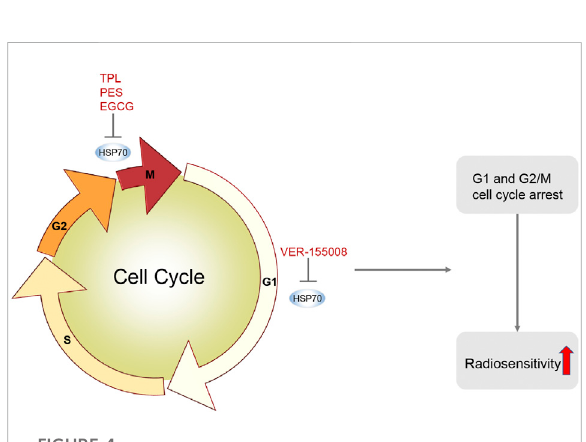
FIGURE 4 HSP70 Inhibitors Induce Cell Cycle Arrest. HSP70 inhibitors induce cell cycle arrest by inhibiting HSP70. For example, TPL induces G2/M phase arrest in nasopharyngeal carcinoma; VER- 155008inducesG1phasearrestinpleuralmesothelioma;PES induces G2/M phase arrest in oral squamous cell carcinoma; EGCG induces G2/M phase arrest in MCF-7 cells in breast cancer. HSP70 inhibitors induce cell cycle arrest, make tumor cells more sensitive to radiotherapy, and increase